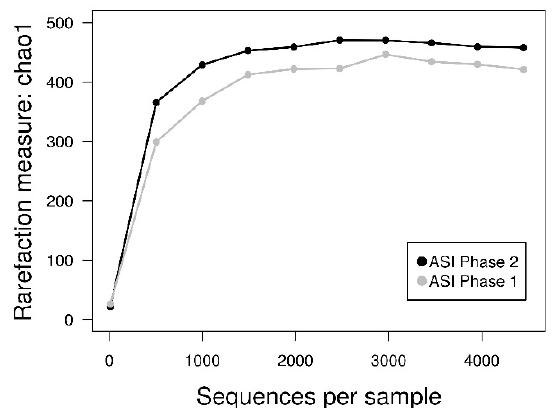
Figure 5. Rarefaction plots of ASI on Phase 1 (gray) and Phase 2 (black). The most representative genera (>1%) in the inocula were Fluviicola sp. (17.70%), a genus of the Clostridiaceae family (11.17%), Azospirillum sp. (10.42%), a genus of Bacteroidales orden (9.60%), and Magnetospirillum sp. (9.37%) (Figure 6). The beta-significance analysis compares the existence of statistical differences between two samples. When was compared, there were no significant differences ( p value = 0.081). The